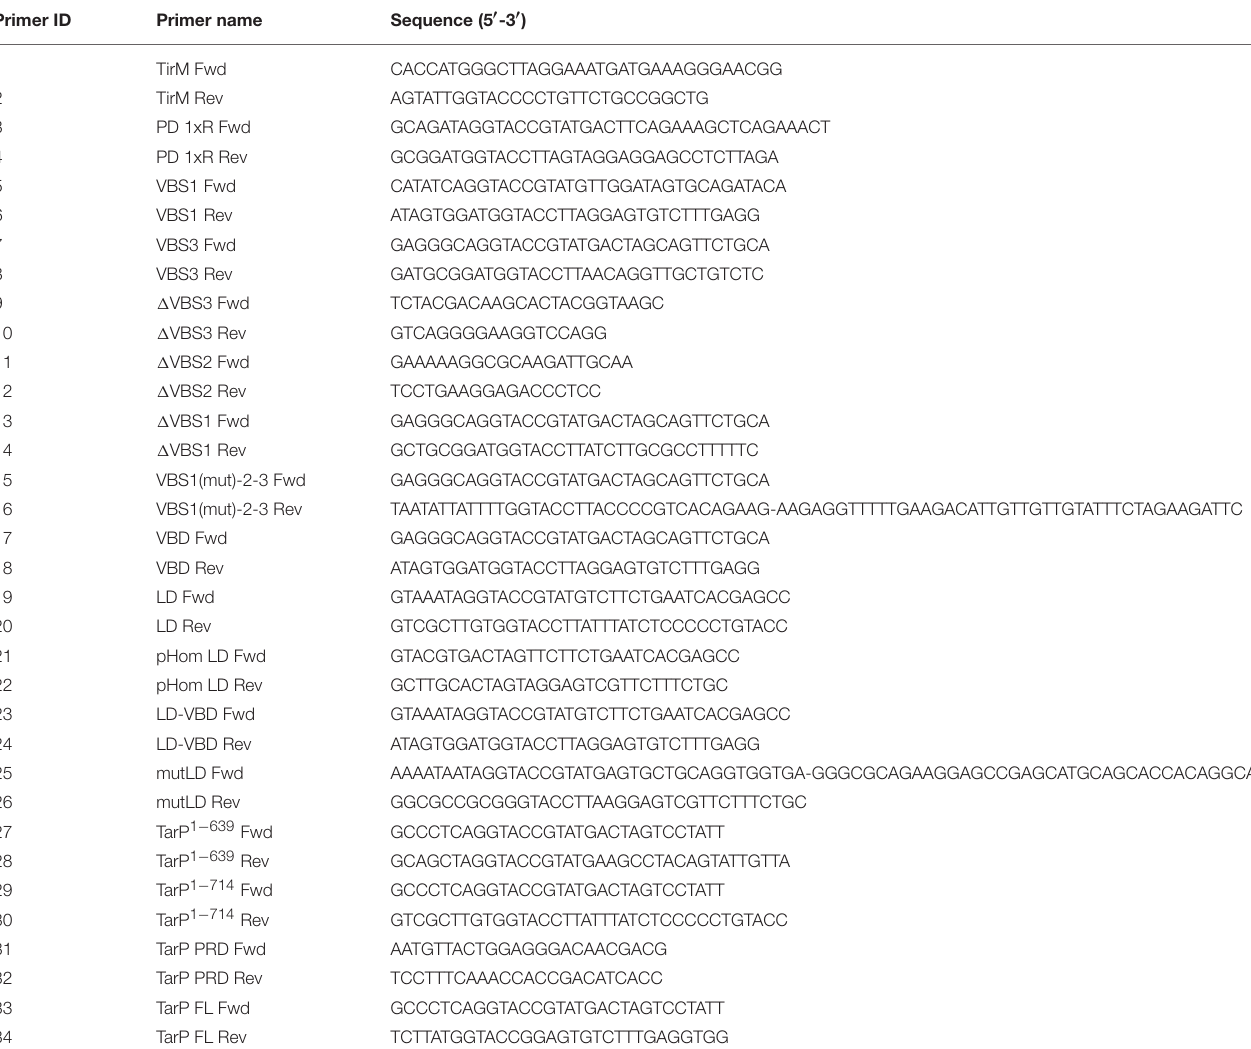
TABLE 1 | Primers used for PCR amplification in this